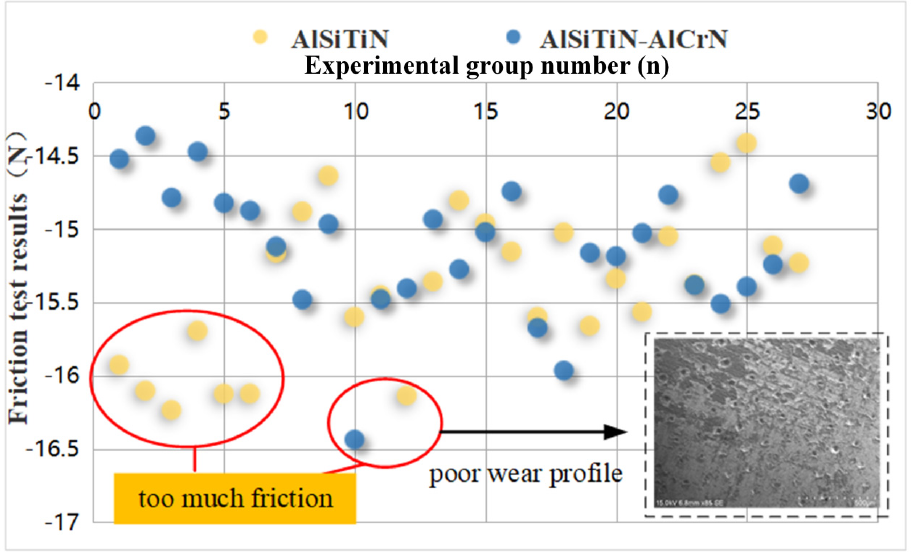
Figure 11. The results of the friction and wear test. (The illustration in the fi gure shows poor wear